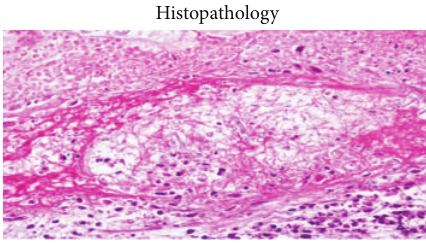
Figure 5: Fungal hyphae in abdominal wall tissue.